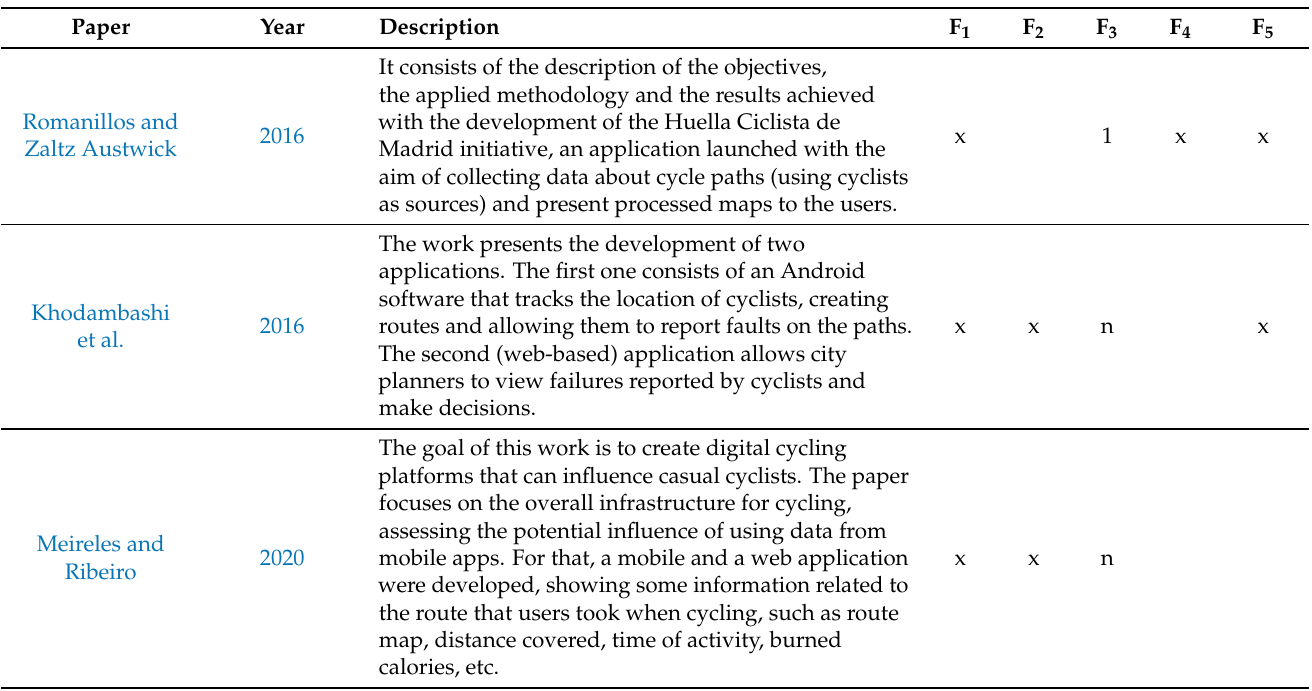
Table 4. Works focused on visualization of cycle paths. Visualization approach features: F 1 —web application, F 2 —mobile application, F 3 —number of cities covered by the application, F 4 —exploits pre-registered cycle paths, F 5 —available for access.